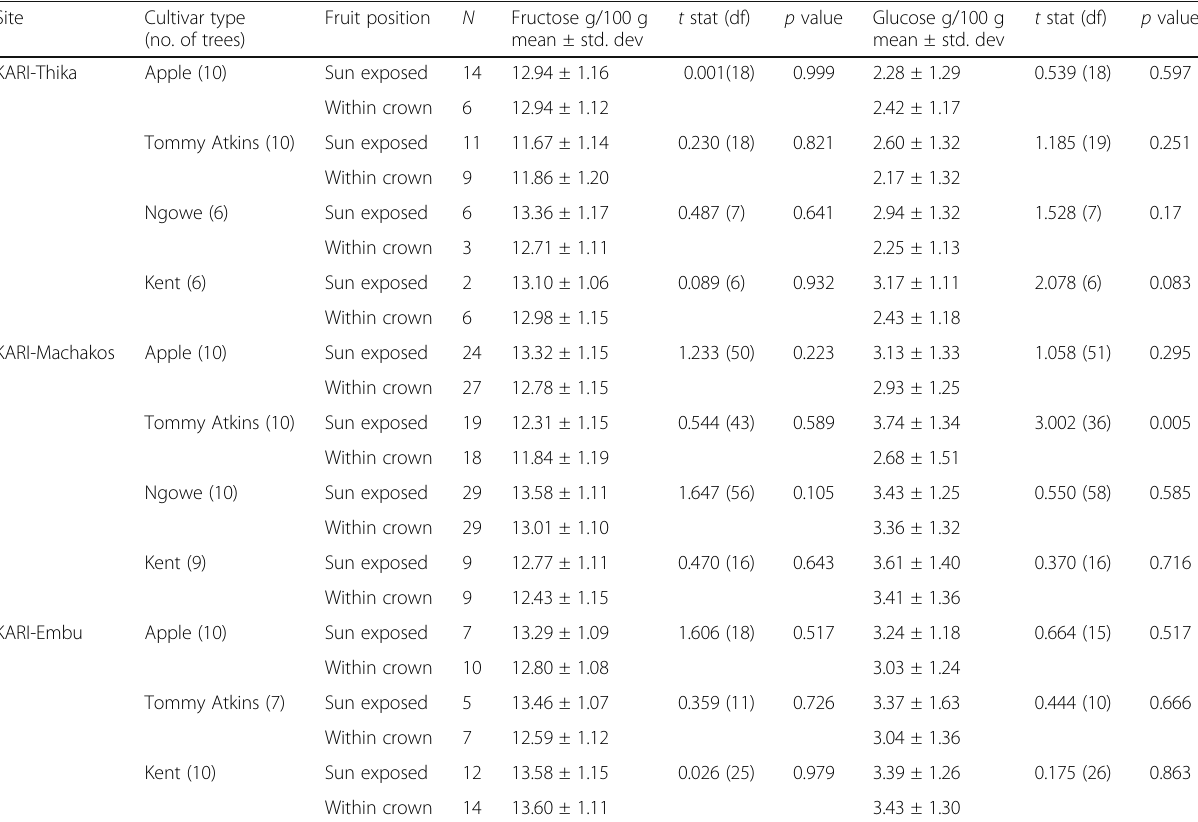
Table 3 An independent t test results examining the means difference in fructose and glucose contents between two fruit positions in four mango cultivars across the three sites Site Cultivar type (no. of